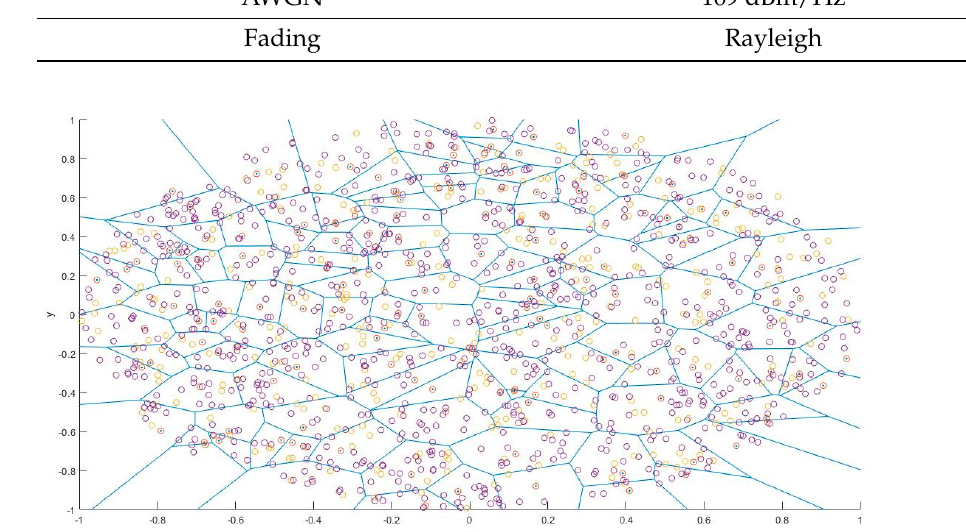
Figure 5. Voronoi tessellation of randomly deployed users under Poisson